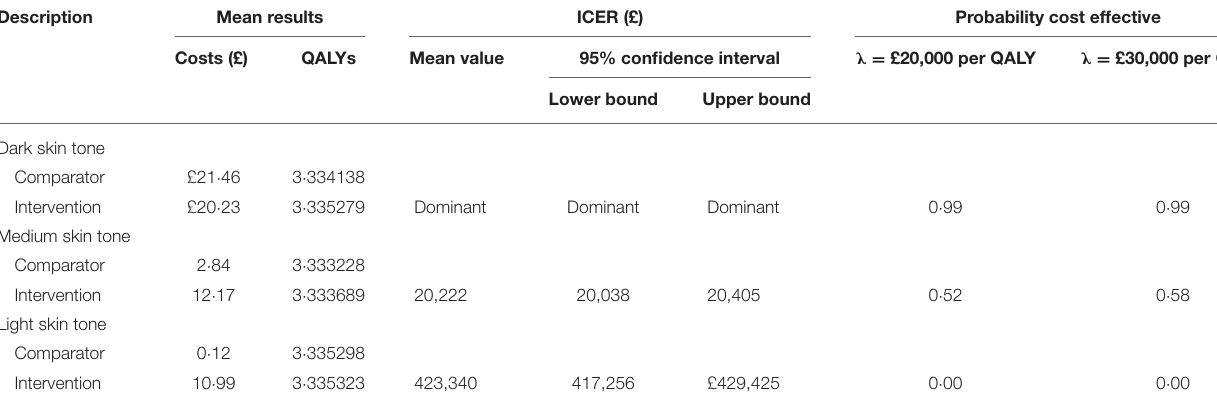
TABLE 8 | Base case analysis results (probabilistic analysis).